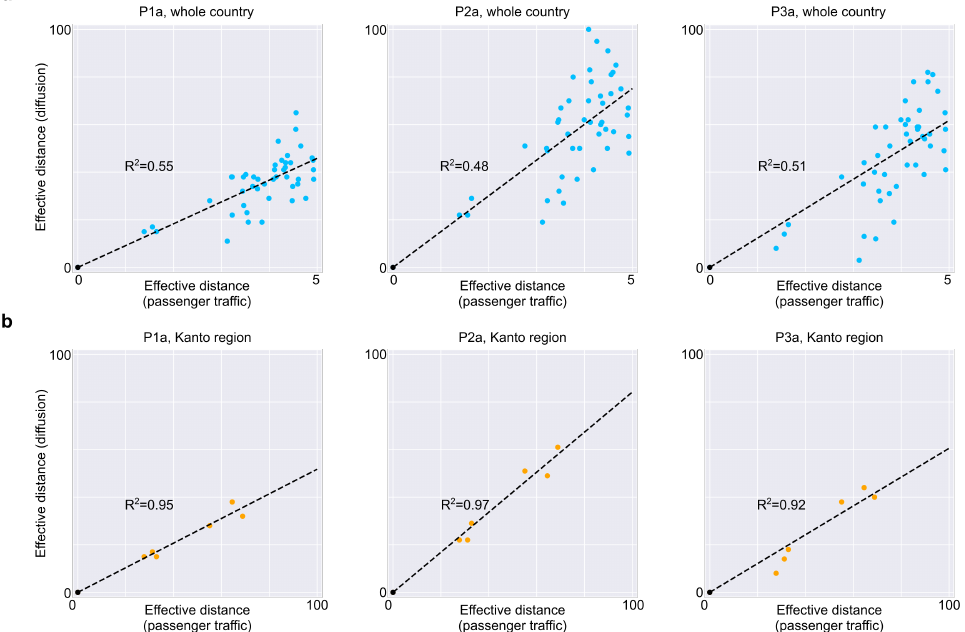
Figure 3. Effective distance derived from diffusion equations contains both passenger traffic and other local information that contribute to the spread of the pandemic. ( a , b ) Relationship between effective distance based on diffusion process from Tokyo and passenger traffic data in 2019 for all prefectures ( a ) and the prefectures in the Kanto region ( b ). A point represents each prefecture, and the prefectures whose effective distance is larger than 100 were excluded. Linear regression by least mean square and correlation coefficients are shown for each